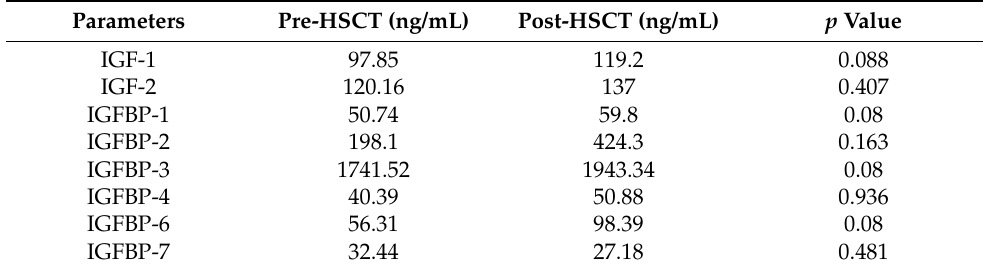
Table 4. Concentrations of IGFs and IGFBPs in pre-HCT and post-HSCT groups.